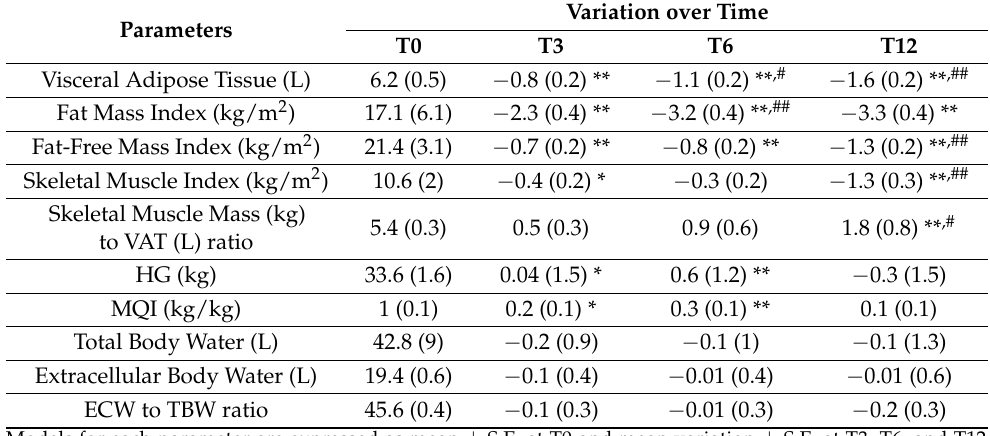
Table 4. Mean changes in bio-impedance parameters describing body composition of study participants. Variation over Time Parameters T0 T3 T6 T12 Visceral Adipose Tissue (L) 6.2